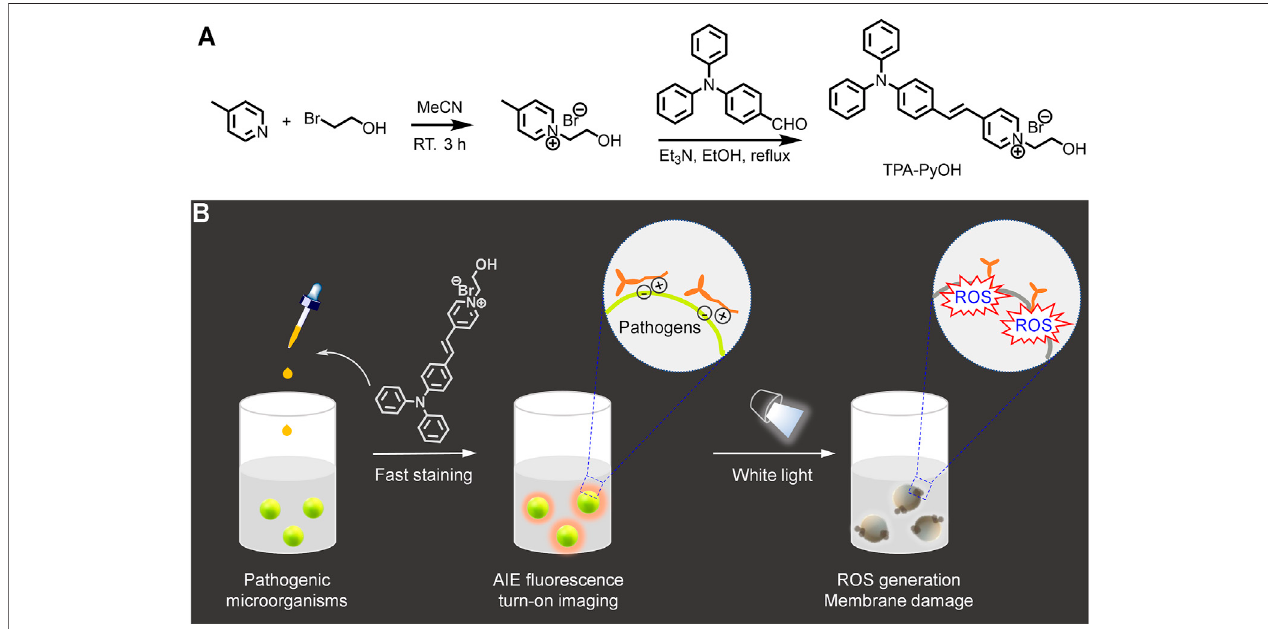
FIGURE1| Schematicillustrationfor (A) thesynthesisofawater-solubleaggregation-inducedemission(AIE)-activephotosensitizer,TPA-PyOH. (B) Itsapplication for fast staining and imaging of pathogenic microorganisms. Upon white light irradiation, reactive oxygen species (ROS) was in situ generated to inhibit pathogens ef fi